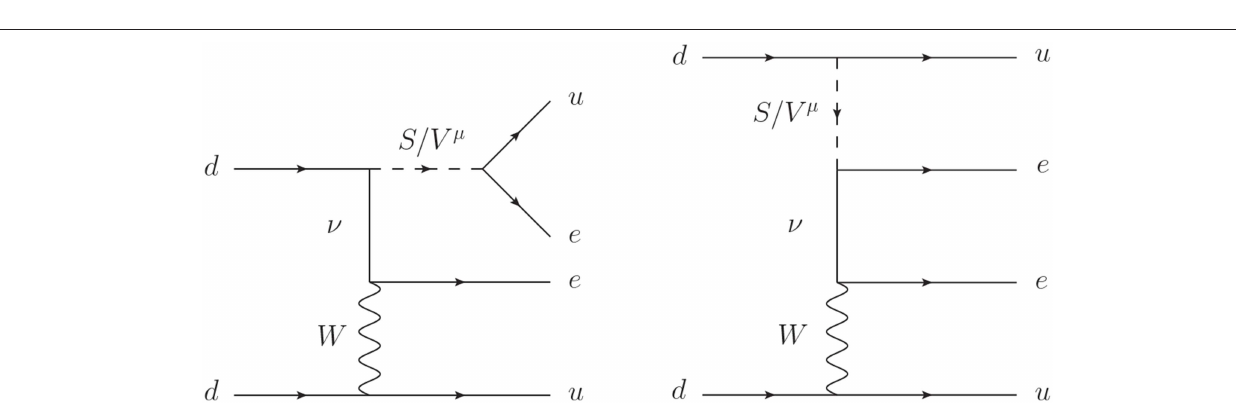
FIGURE 18 | The exotic 0 νββ decay mechanisms involving scalar or vector leptoquarks S , V µ .